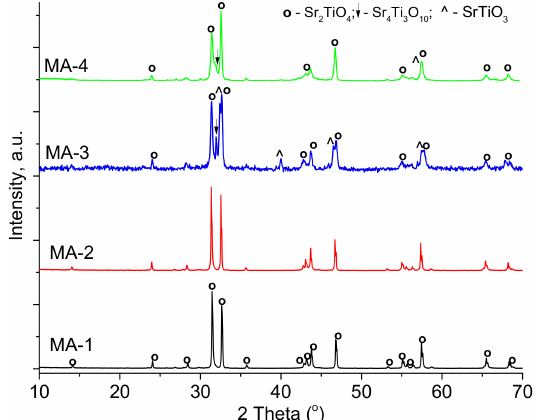
Figure 7. XRD patterns of the samples annealed at 1100 ◦